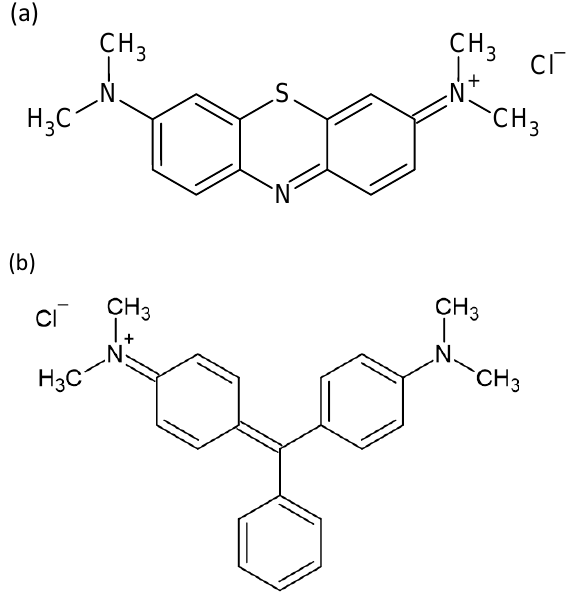
Figure 1. Chemical structure of ( a ) methylene blue (MB) and ( b ) malachite green (MG) [6,7]. The adsorption of the solute using inorganic adsorbents is widely applied due to the chemical and thermal stabilities as well as the ability of the adsorbents to be regenerated [8]. The adsorption of organic waste is highly dependent on the adsorbent properties: porosity, high surface area, and good mechanical and thermal stability. These properties can be easily found on silica-based materials. Popular silica-based adsorbents include silica beads, alunite, perlite, dolomite, and zeolite [8]. Silica-based adsorbents have been reported to be efficient in the removal of a wide range of dyes in a batch system including anionic [9], reactive, and cationic [10]. A silica–polymer hybrid (H HPMA ) synthesised by Jamwal et al. was more effective and selective in MB adsorption compared to MG and Congo red, with a maximum adsorption capacity of 56.6 mg/g [10]. Mobarak et al. reported the maximum adsorption capacity of 75.5 mg/g for cobalt ferrite silica nanocomposite, with the highest MG removal (>90.0%) at pH 6 [11]. In another study, Zirak et al. found that increasing the adsorbent dosage of the carboxymethyl cellulose magnetic nanoparticles (CMC-Fe 3 O 4 @SiO 2 ) led to a decrease in MB removal due to adsorbent aggregation. The study limited the adsorbent dosage to 0.03 g and obtained the maximum adsorption capacity of 22.7 mg/g